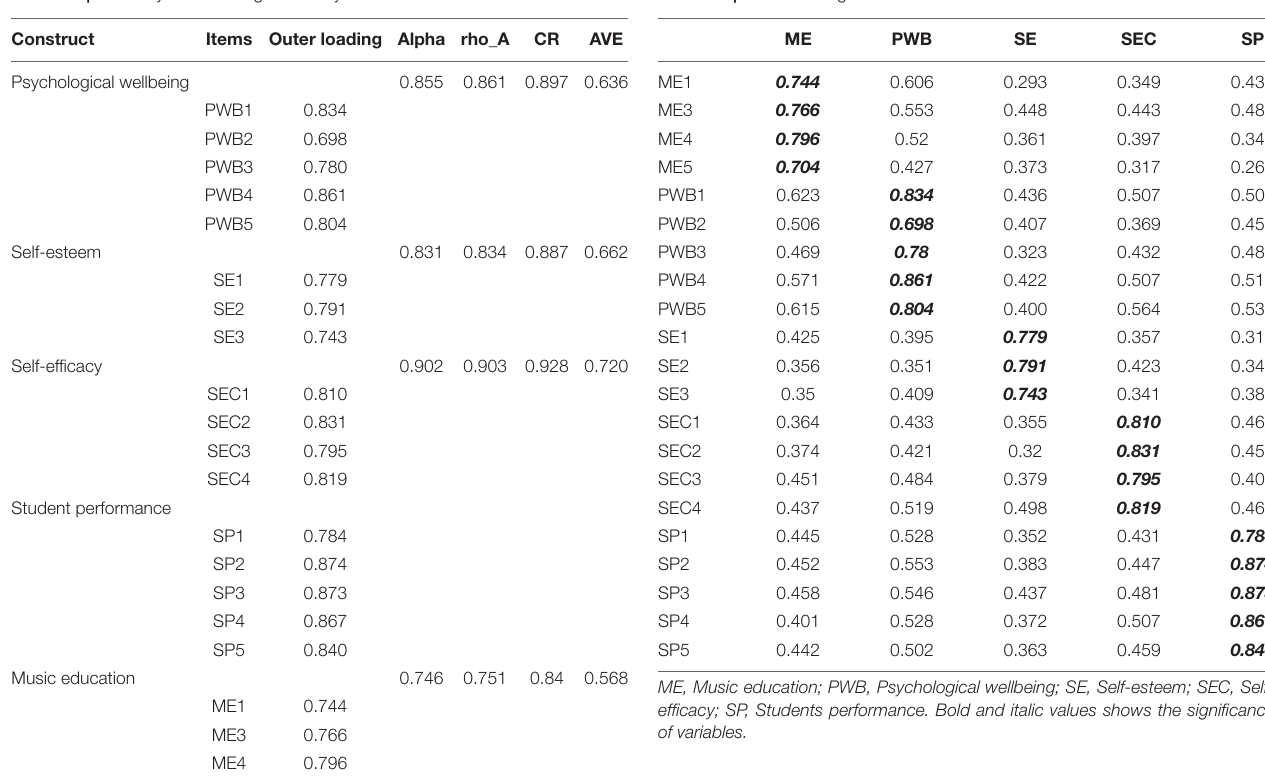
TABLE 2 | Reliability and convergent validity.